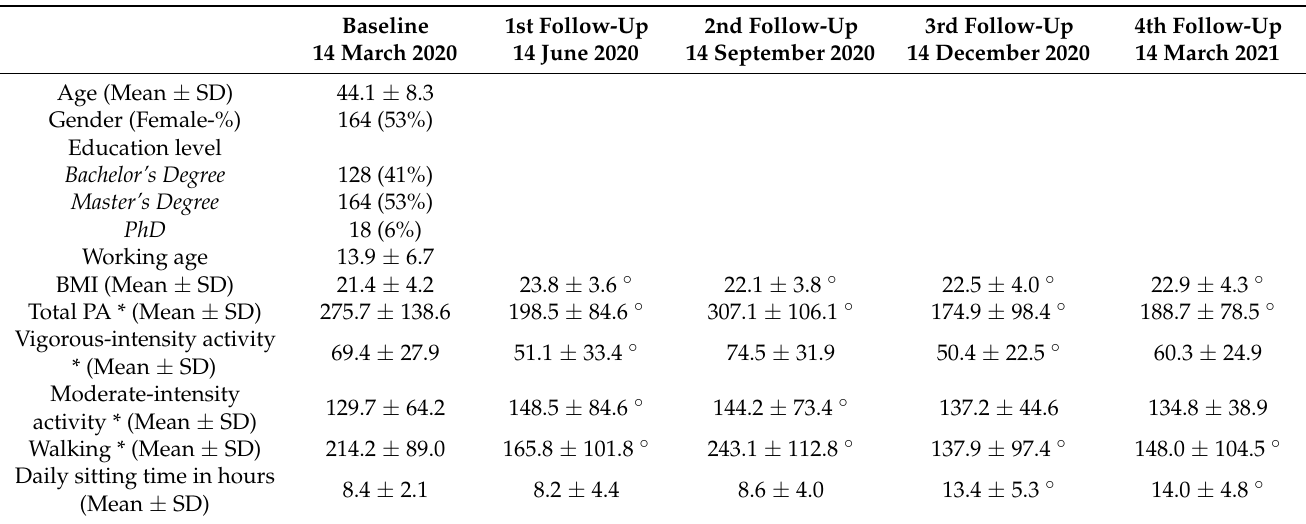
Table 1. Sociodemographic characteristics of workers participating in the survey and IPAQ-SF results.